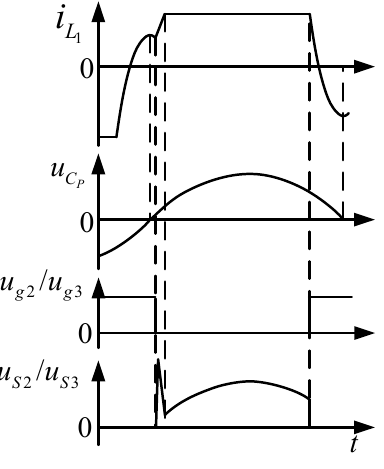
Figure 9. Waveform when L 1 is too large.